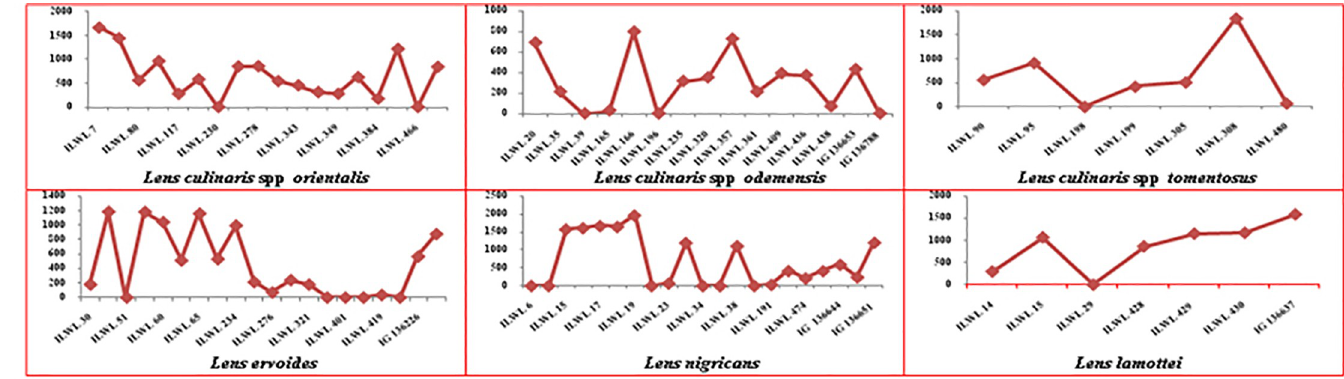
Fig 5. Screening of wild lentil accessions against powdery mildew